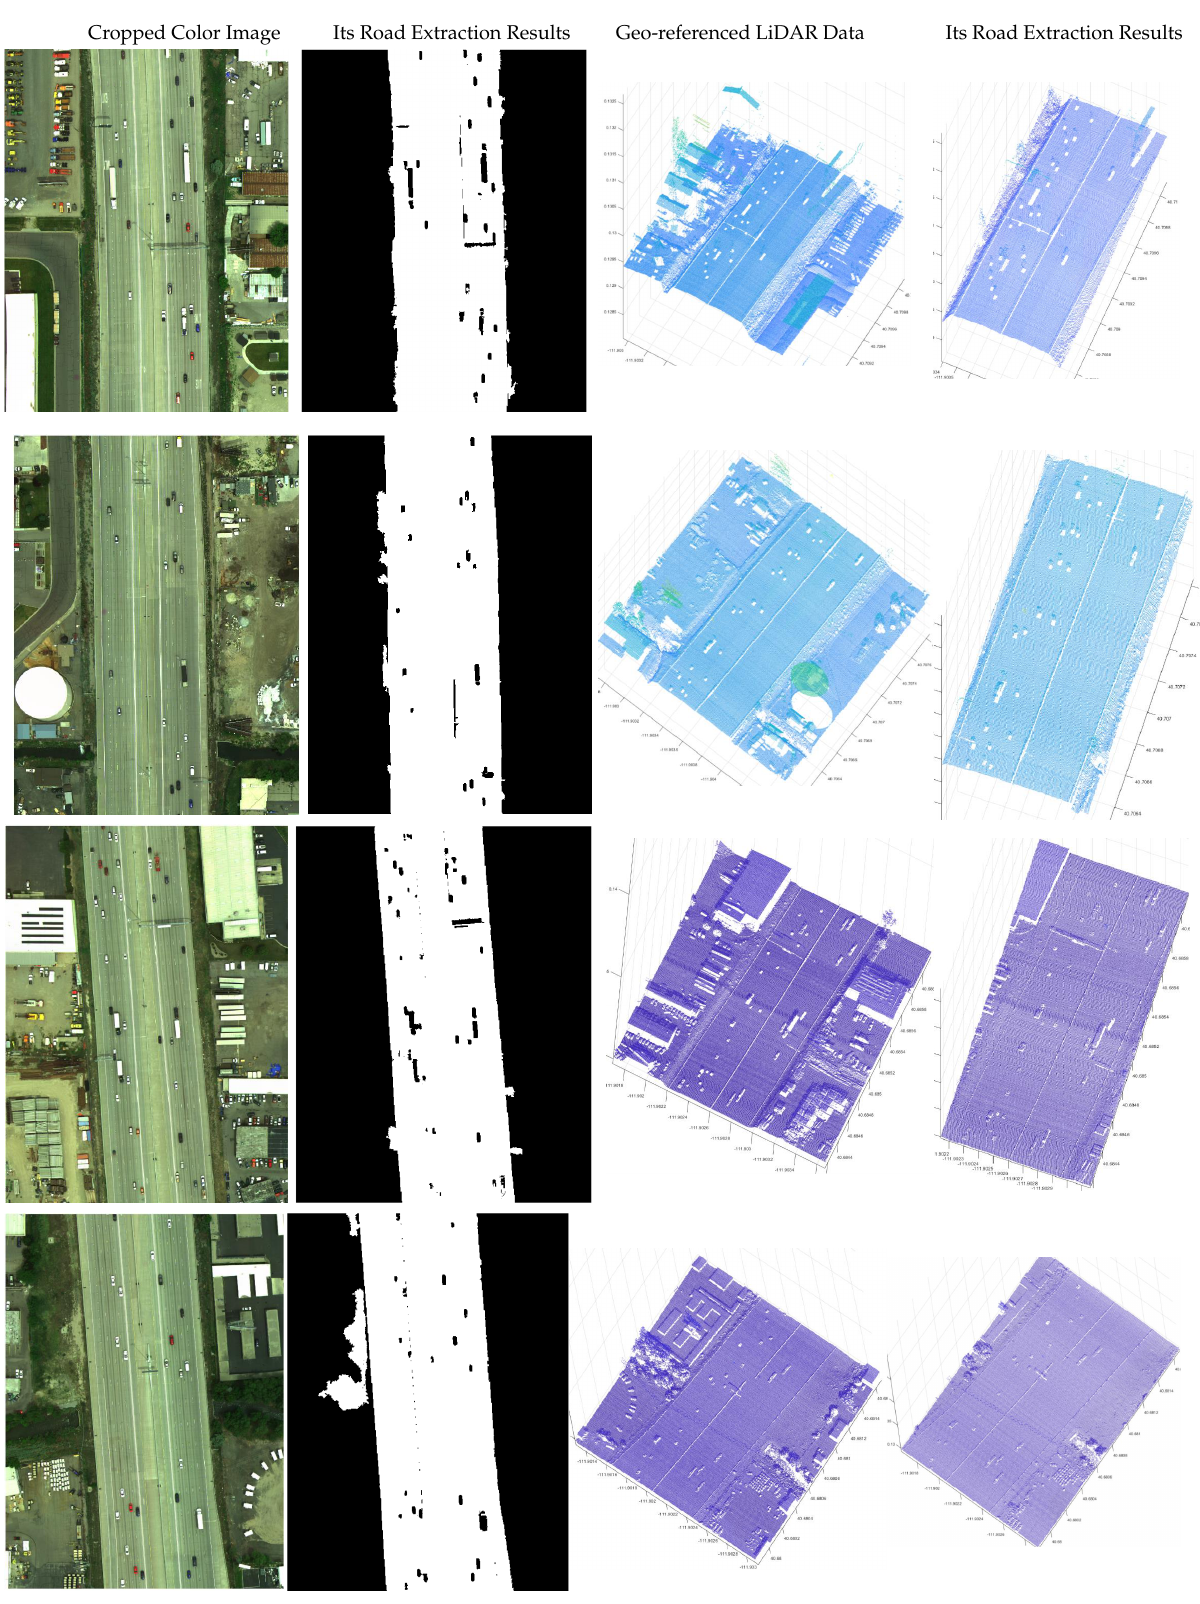
Figure 7. Road extraction results in both color images and their associated LiDAR data for four cropped